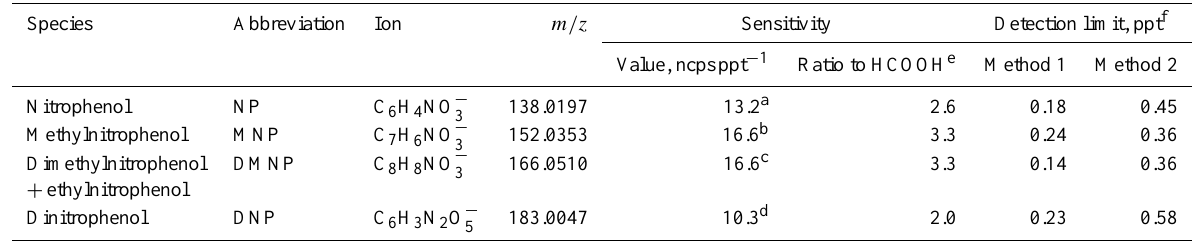
Table 1. Sensitivities and detection limits of nitrated phenols in acetate ToF-CIMS.